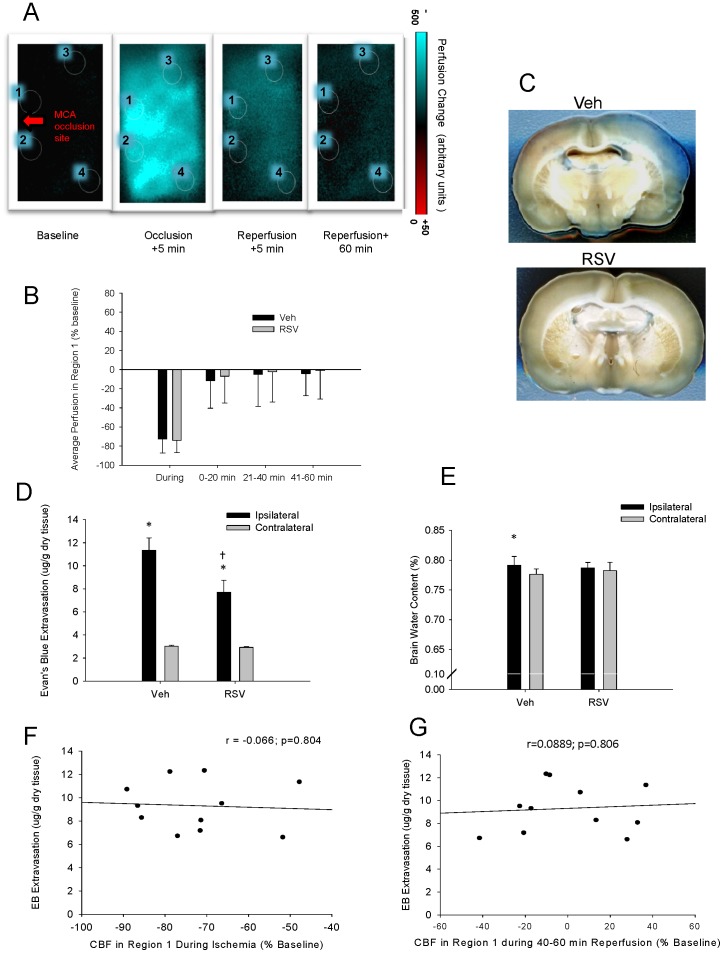
Representative color-transformed laser speckle difference images (A) showing regional perfusion changes relative to baseline values for an animal during recurrent mild stroke that was produced three days following an initial mild stroke.Perfusion values were assessed in four different regions (1 to 4) for each animal according to positions relative to the site of middle cerebral artery occlusion (arrow). Mean perfusion values were similar in resveratrol (RSV) and Vehicle (Veh) treated rats for all regions at all time points with mean values for Region 1 shown in Panel B. In the same animals, blood brain barrier function was assessed with Evans Blue and (C) shows representative coronal slices of brain from rats treated with resveratrol (RSV) and Vehicle (Veh) showing greater Evans Blue extravasation indicative of BBB dysfunction in Veh treated rats. The amount of Evans Blue present in the cortex was quantified using fluorescent spectrometry (E) and RSV-treated rats had significantly less Evans Blue extravasation in the ipsilateral cortex compared with Veh-treated rats. Resveratrol treatment also prevented edema, as only Veh-treated rats showed a significant increase in cortical brain water weight (F) on the injured side two days post-stroke. The extent of Evans blue extravasation was not correlated to the regional perfusion changes (e.g. in Region 1), either during recurrent stroke (G) or after recurrent stroke (H), indicating that blood-brain barrier disruption did not depend on acute flow differences between groups. * p<0.05, different from contralateral (Student's paired t-test). † p<0.001, different from Veh (ANOVA with a Student-Newman Keuls test).